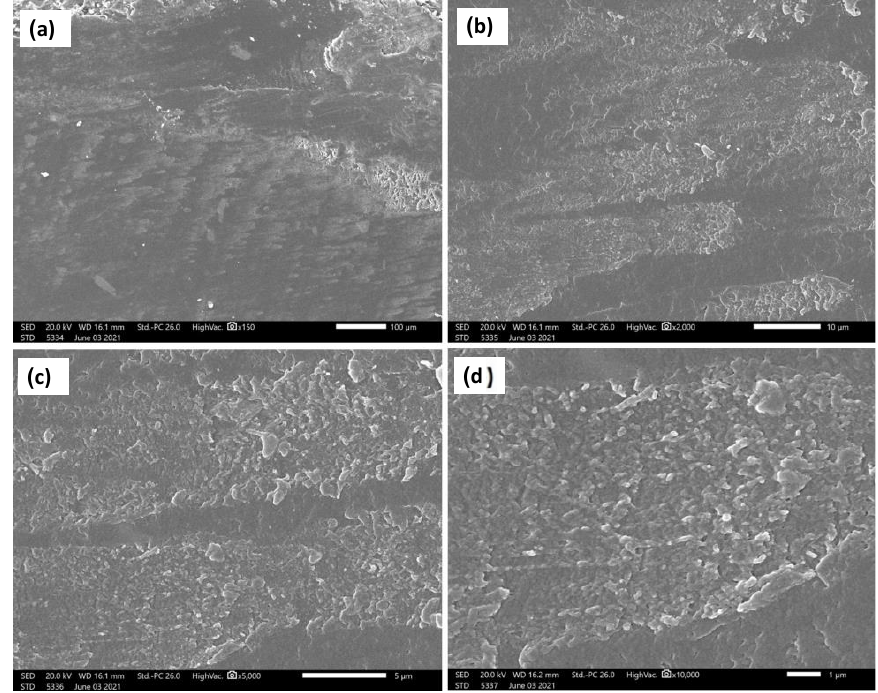
Figure 14. SEM micrographs at different magnifications and positions of the 10wt% ZrO2 acrylic nanocomposite material after wear test. ( a ) 150×, ( b )2000×, ( c ) 5000× and ( d )10,000×.